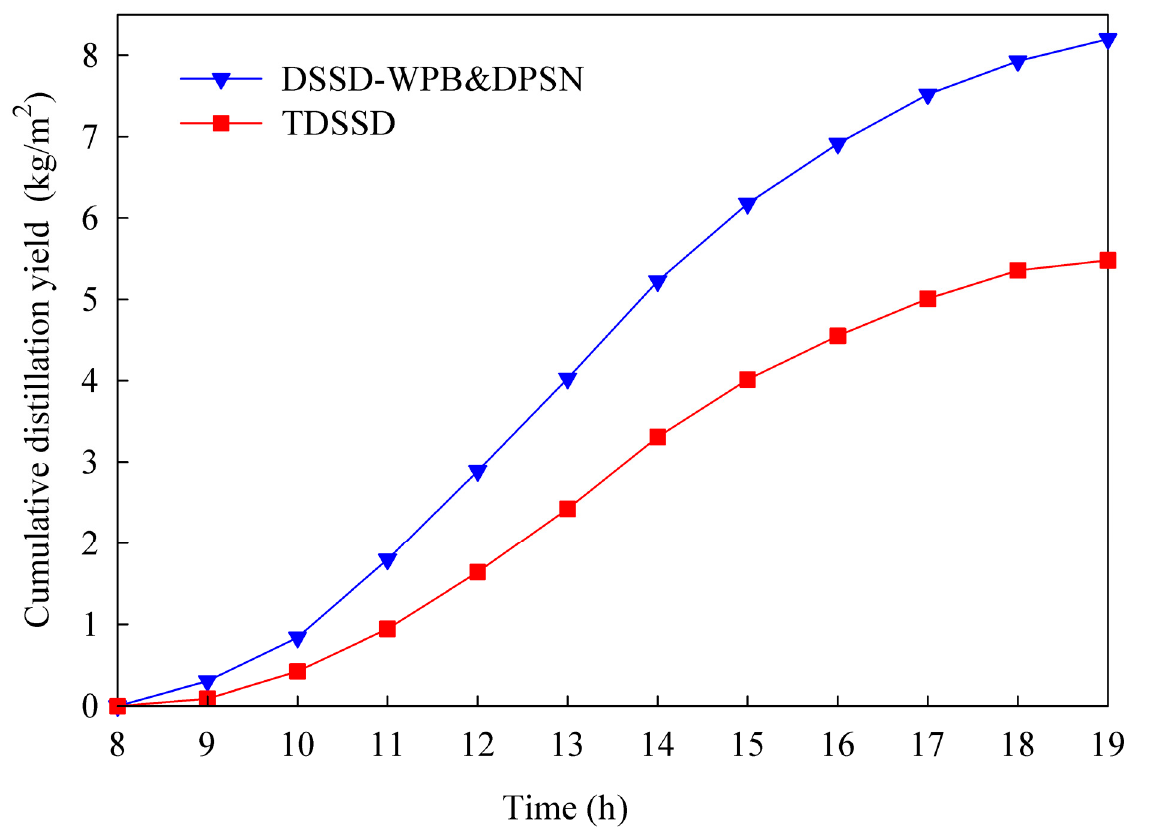
Figure 7. Time dependence: cumulative distillation yield for DSSD-WPB&DPSN and TDSSD.